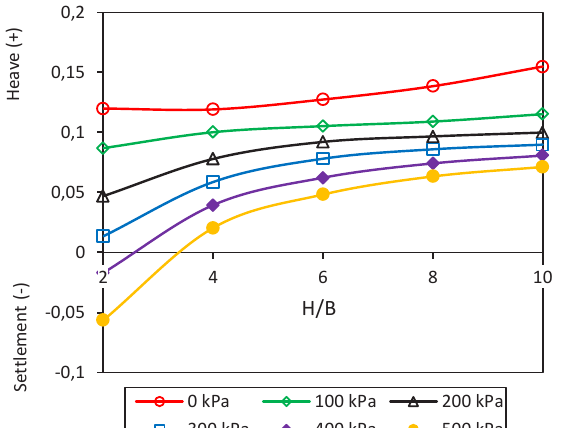
Figure 11: Variation of vertical swelling strain ε square footing with H⁄B ratio and σ